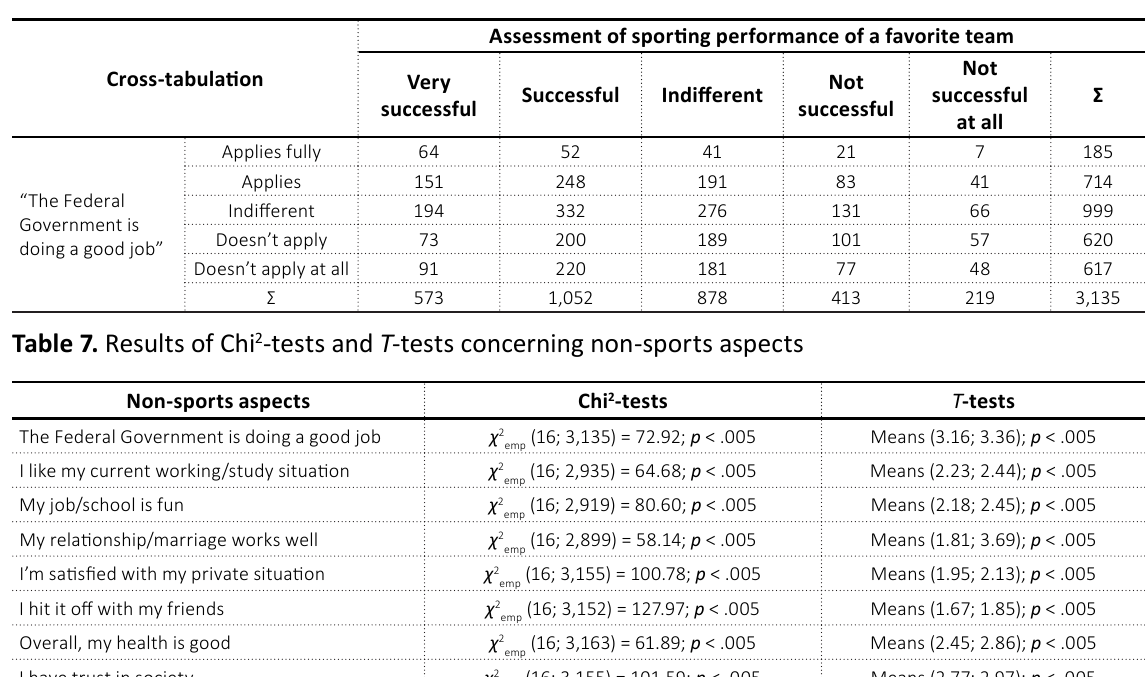
Table 6. Cross-tabulation of assessment of sporting performance and satisfaction with the job of the